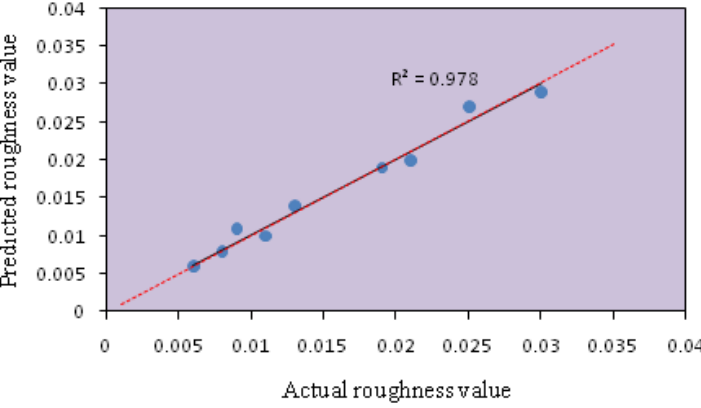
Figure 2. Scatter plot of coded predicted RMS roughness value versus actual RMS roughness value from the Taguchi experimental